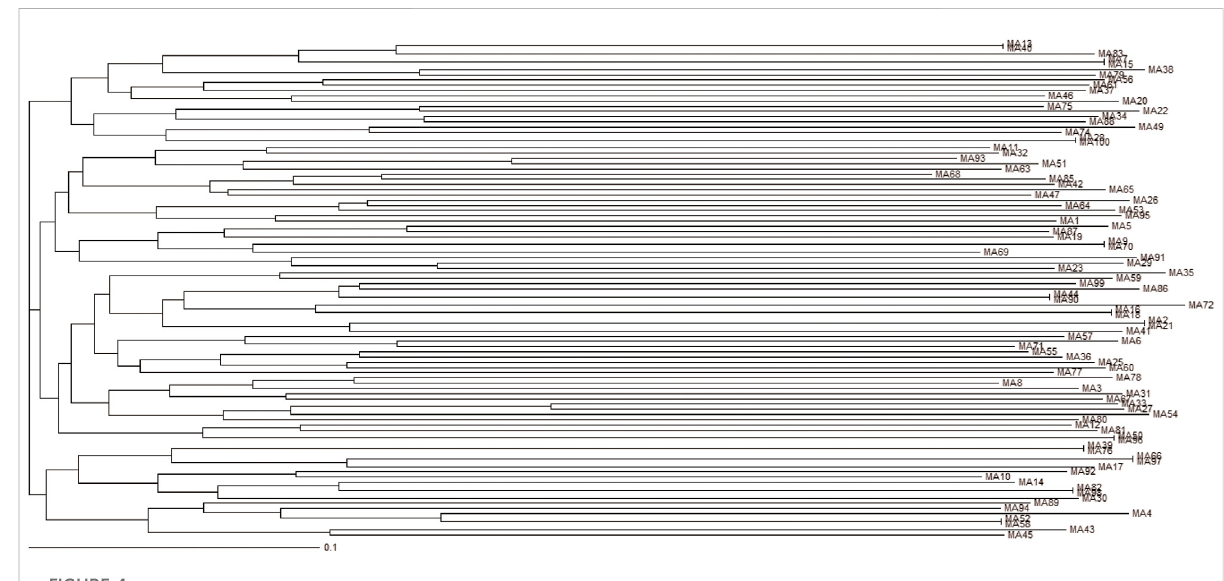
Phylogenetic dendrogram. Multiple Alignment of aptamers identi fi ed following cloning of the last hypoxic cell-SELEX round and sequencing. Dendrogram using Clustal Omega Multiple Sequence Alignment tool by